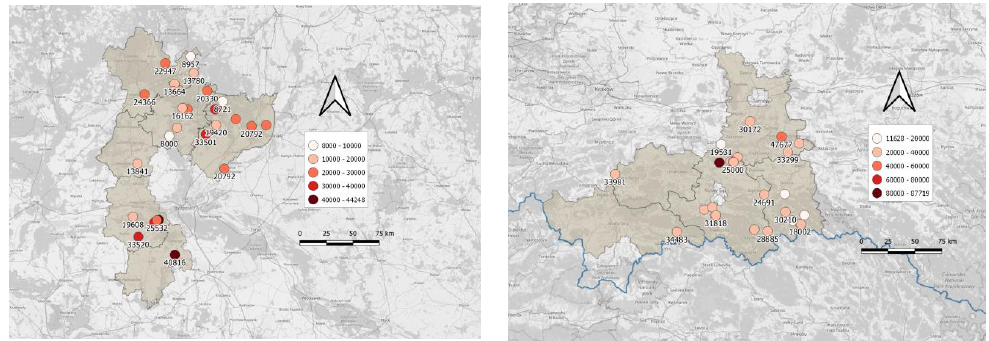
Figure 4. Spatial distribution of forest property sales sales within the study areas. Source: own elaboration. ( left ) North (Swiecie, Tuchola, Naklo, Sepolin, Znin, and Chojnice). ( right ) South (Gorlice, Nowy Sacz, Limanowa, and